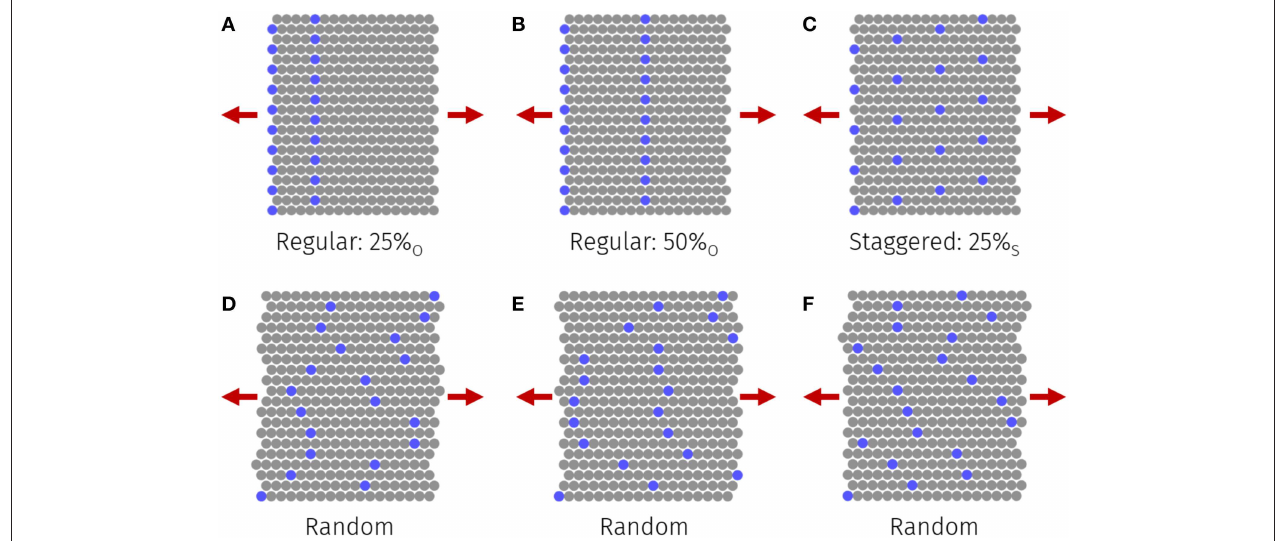
FIGURE 1 | CNC nanopapers ( L = 50 nm) with (A) 25% O and (B) 50% O regular and (C) 25% S staggered offset between neighboring fibers. x % O and x % S refer to regular and staggered offset structures with x % offset between neighboring fibers, respectively. (D–F) Three representative realizations of CNC films ( L = 50nm) with random ordering. Red arrows indicate direction of applied